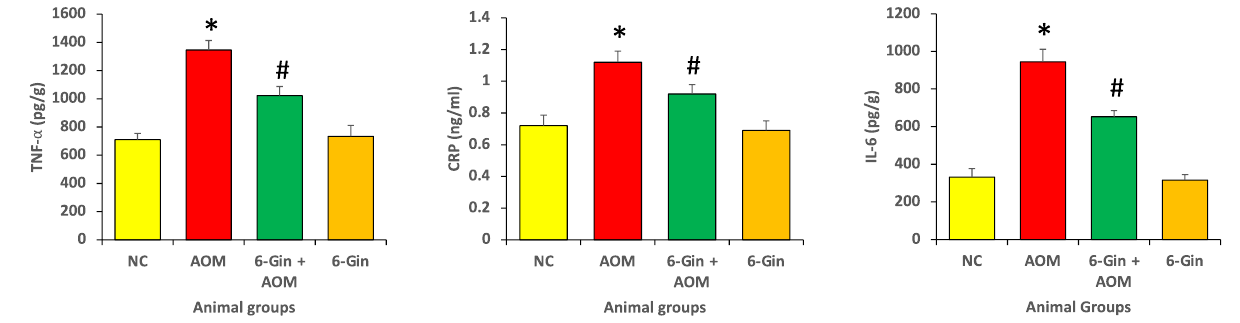
Figure 2. The anti-inflammatory effect of 6-Gingerol on the azoxymethane-induced inflammatory cytokine level. Data are represented as ± standard error of mean (SEM). The different groups are NC as normal control, AOM as azoxymethane treatment group (disease control), 6-Gin + AOM as 6-gingerol treatment to disease control and 6-Gin as only 6-gingerol treatment group. The * indicates significant difference ( p < 0.05) between disease control vs. normal control and # indicates significant difference ( p < 0.05) between disease control and disease control with treatment.